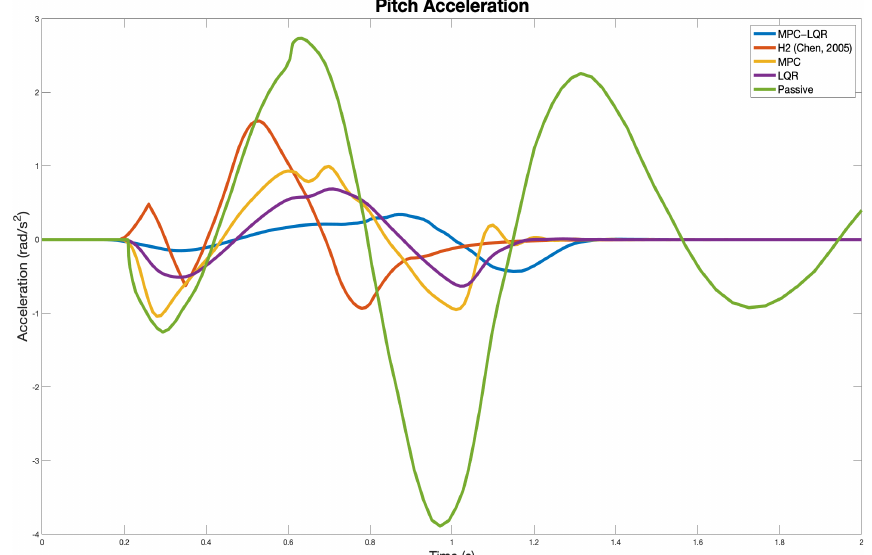
Figure 7. Pitch Acceleration (Blue—MPC-LQR, Red—H2, Yellow—MPC, Purple—LQR, Green—